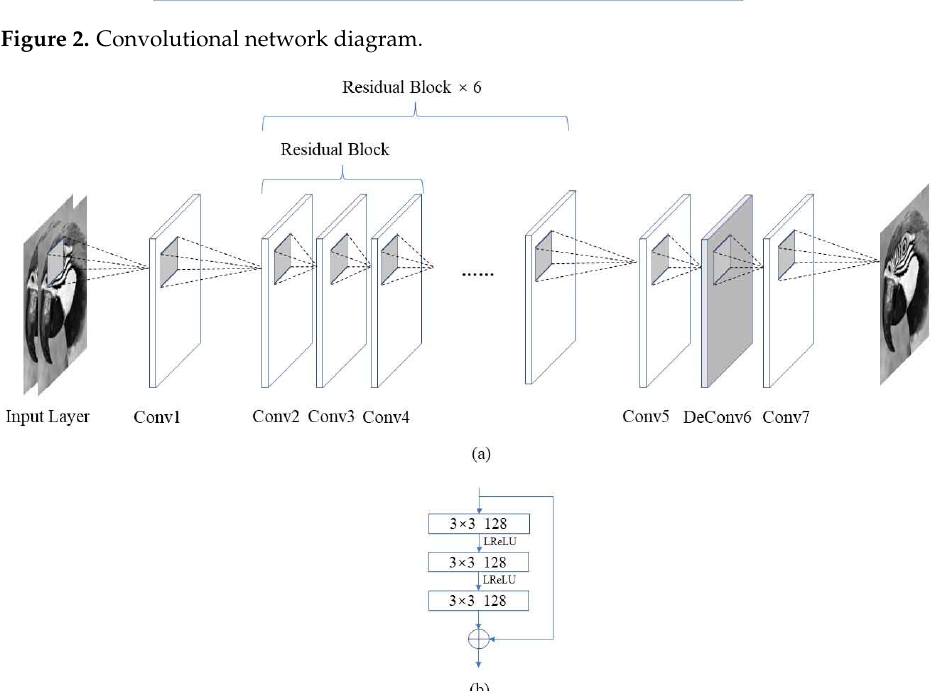
Figure 3. The designed network details of each convolutional layer. ( a ) Convolutional neural network structure. ( b ) Residual connection. Table 1. The parameter settings of Convolutional Neural Network.